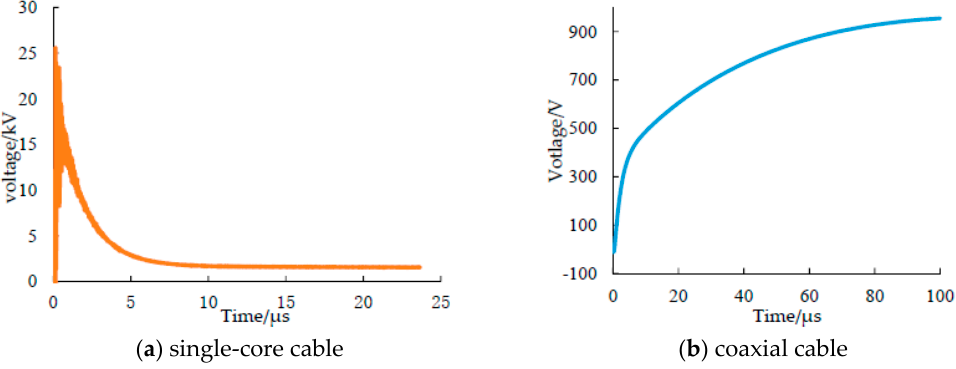
Figure 3. Induced voltage in the cables in the nacelle.